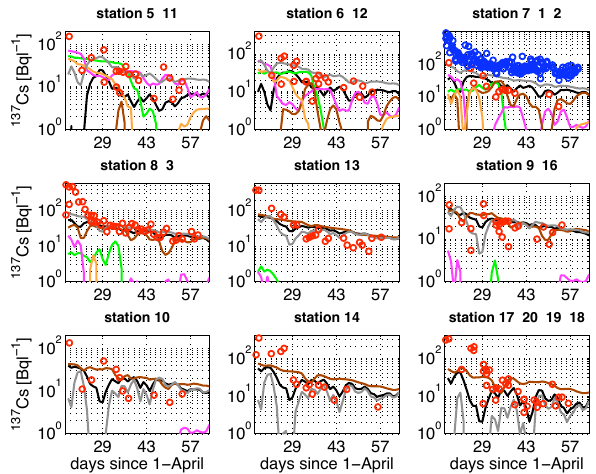
Fig. 8. Observed (red o and vertical bars) by MEXT and simu- lated (colored lines) time series of surface 137 Cs activities at dif- ferent stations as indicated by panel titles. The red vertical bars denote samples hosting 137 Cs activities below the detection limit ( ≈ 10Bql − 1 ). The station numbers are assigned to locations in Fig. 2. The black, green, magenta, brown, orange lines correspond to simulated nominal years 1993 to 1997, respectively. The grey lines correspond also to simulated year 1993 but with 137 Cs depo- sitions being applied one week later. Note, that at station [4], day 14 a reading of 186Bql − 1 is not shown.